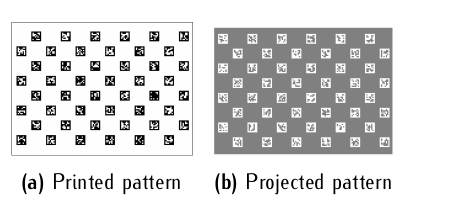
Figure 4. A set of Gray coded patterns